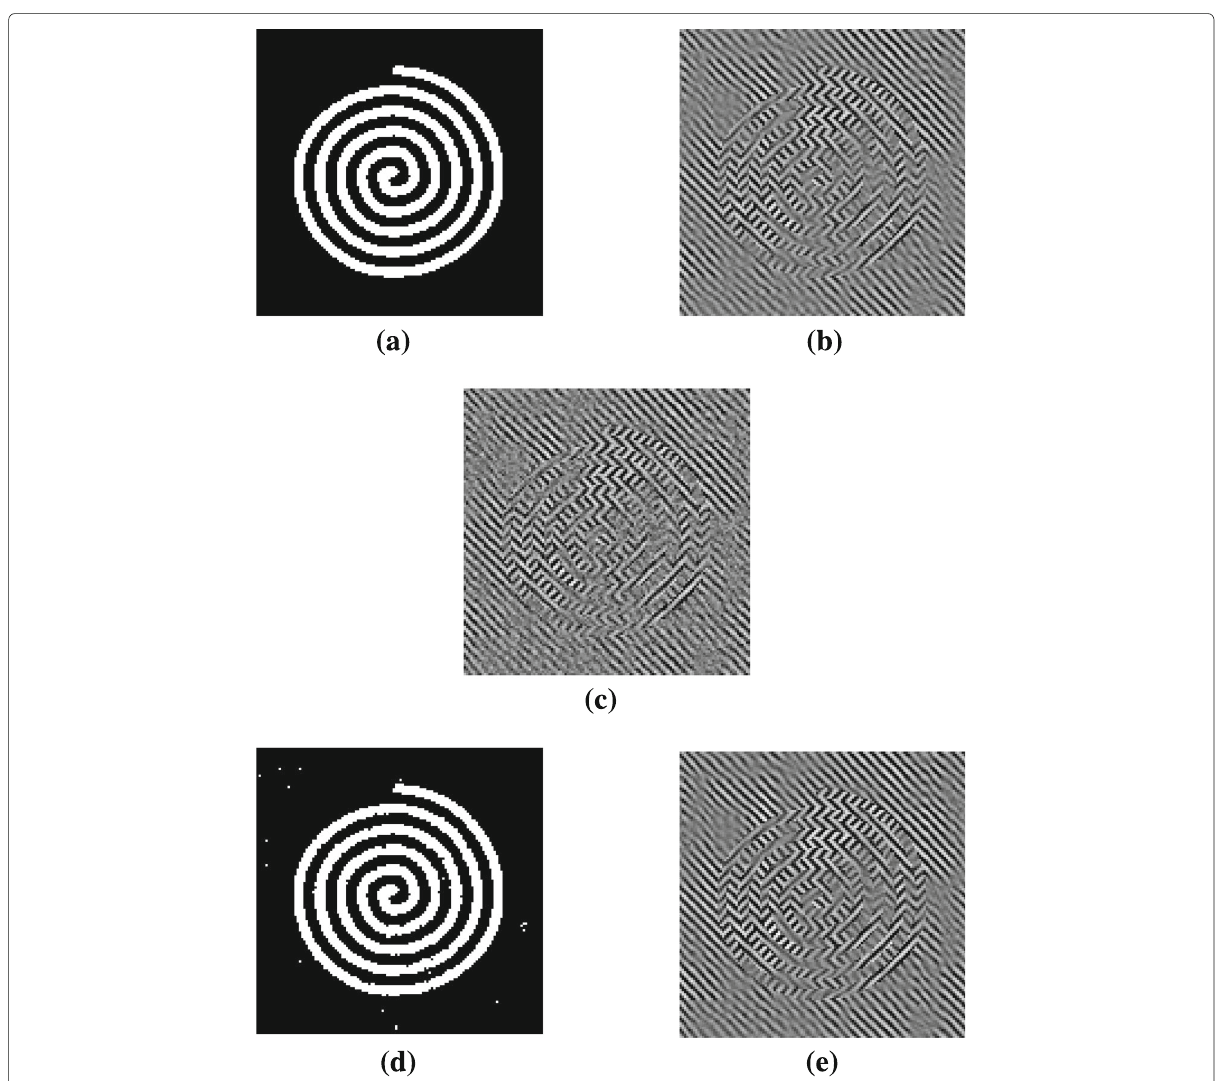
Fig. 6 Segmentation and reconstructed images (Example 2). a True labels (cid:2) ∗ . b True image z ∗ . c Data y . d Estimated labels ˆ (cid:2) . e Estimated image ˆ